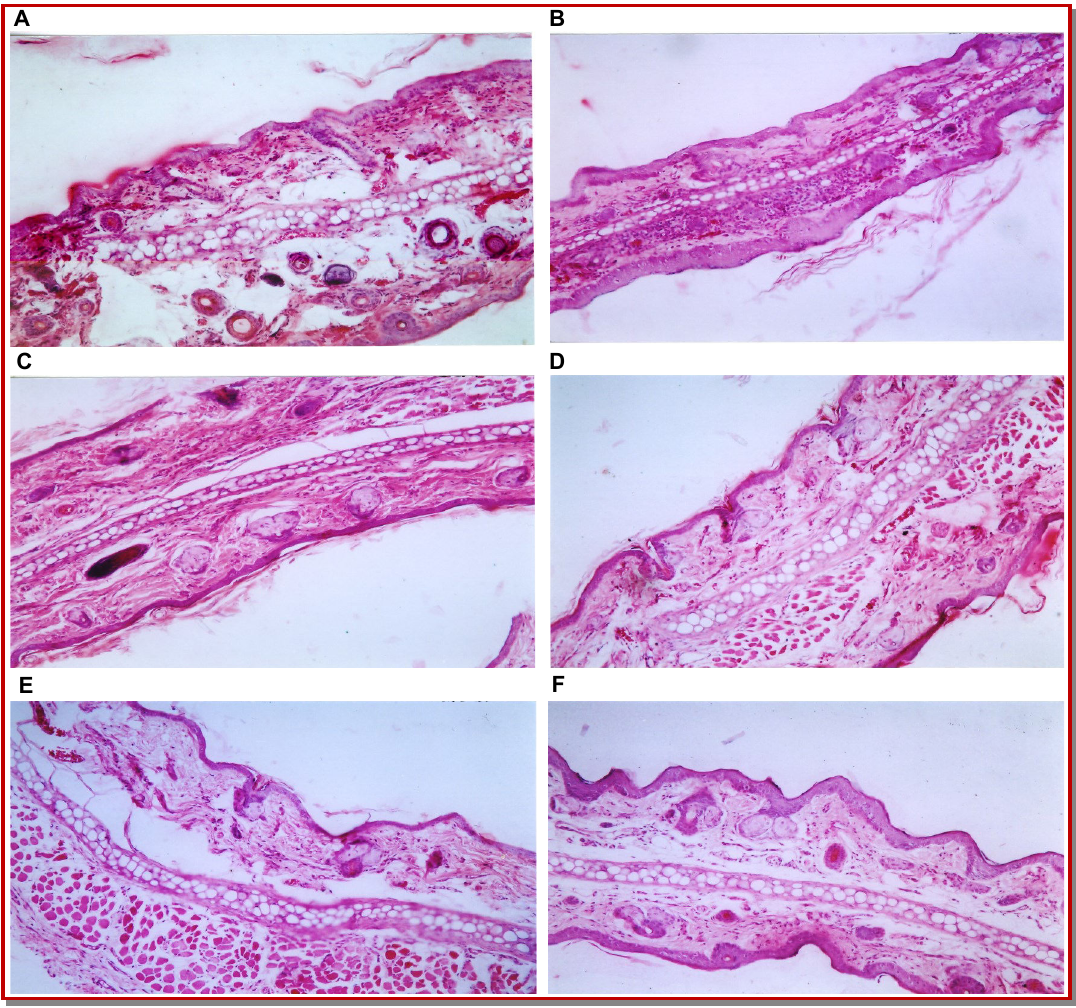
Figure 1: Motherwort total base of acne model rats auricle histologic changes of the organization HE ×100 ） Note: A. Blank group; B. Model group; C. Danshentong group; D. High dose of TALH group; E. Medium dose of TALH group; F Low dose of TALH